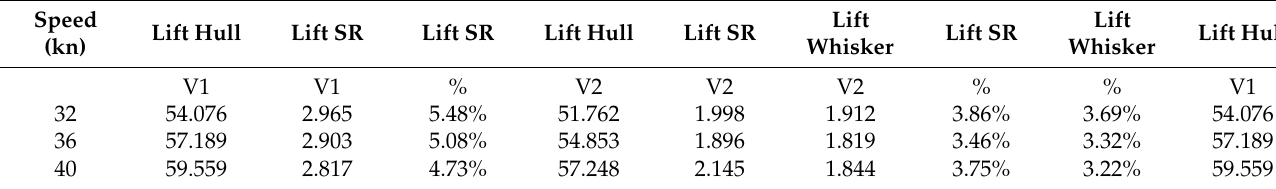
Table 15. Comparison of lift computed on SR.